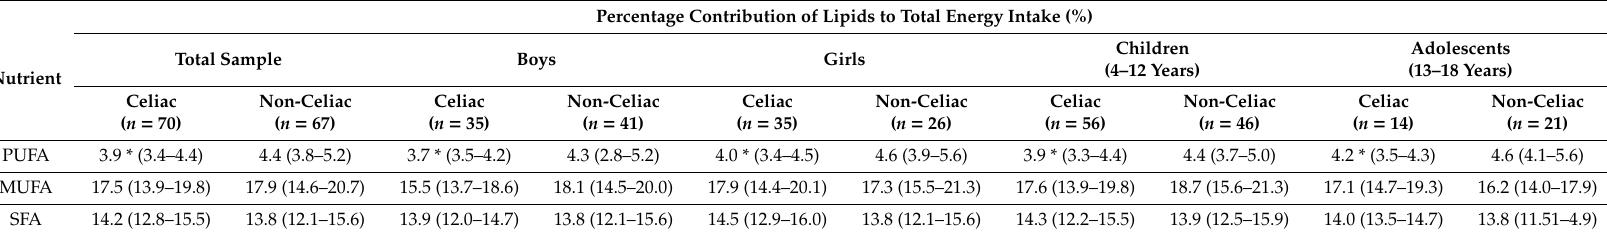
Table 4. Lipid intake in the diet of celiac and non-celiac children and adolescents.